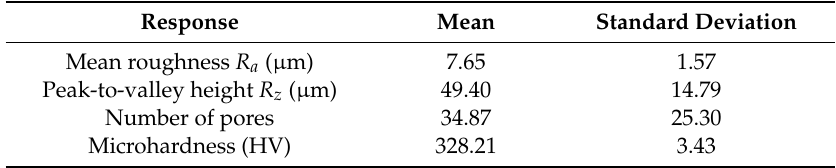
Table 6. Mean and standard deviation of each response for VED in the range 60–480 J · mm − 3 .